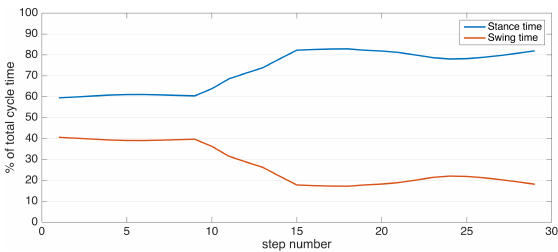
Figure 19. Change of stance and swing time ratios due to fatigue (Subject